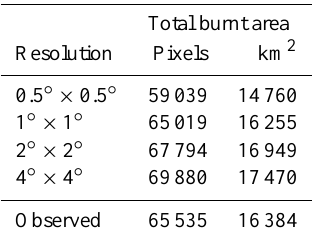
Table 1. Total burnt area estimates over the study region, in pixels and km 2 , for each